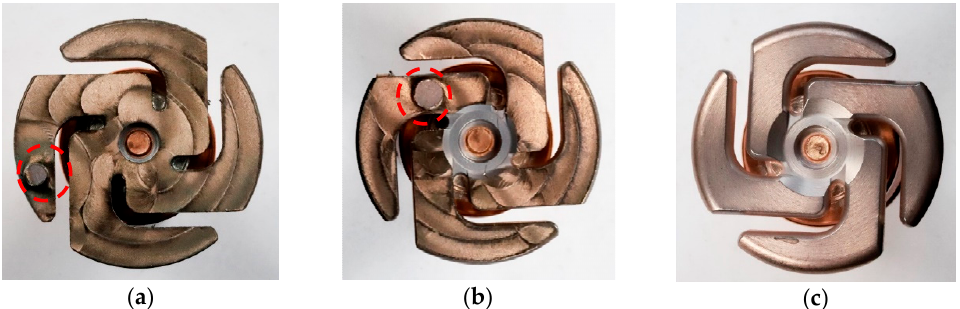
Figure 2. Examples of CuCr electrodes used in the study. Red circles show the prepared contact spots for arc ignition, type A ( a ) and type B ( b ). The anode ( c ) was not modified. These initial contact spots had diameters of about 3 mm. Only the cathodes were modified in